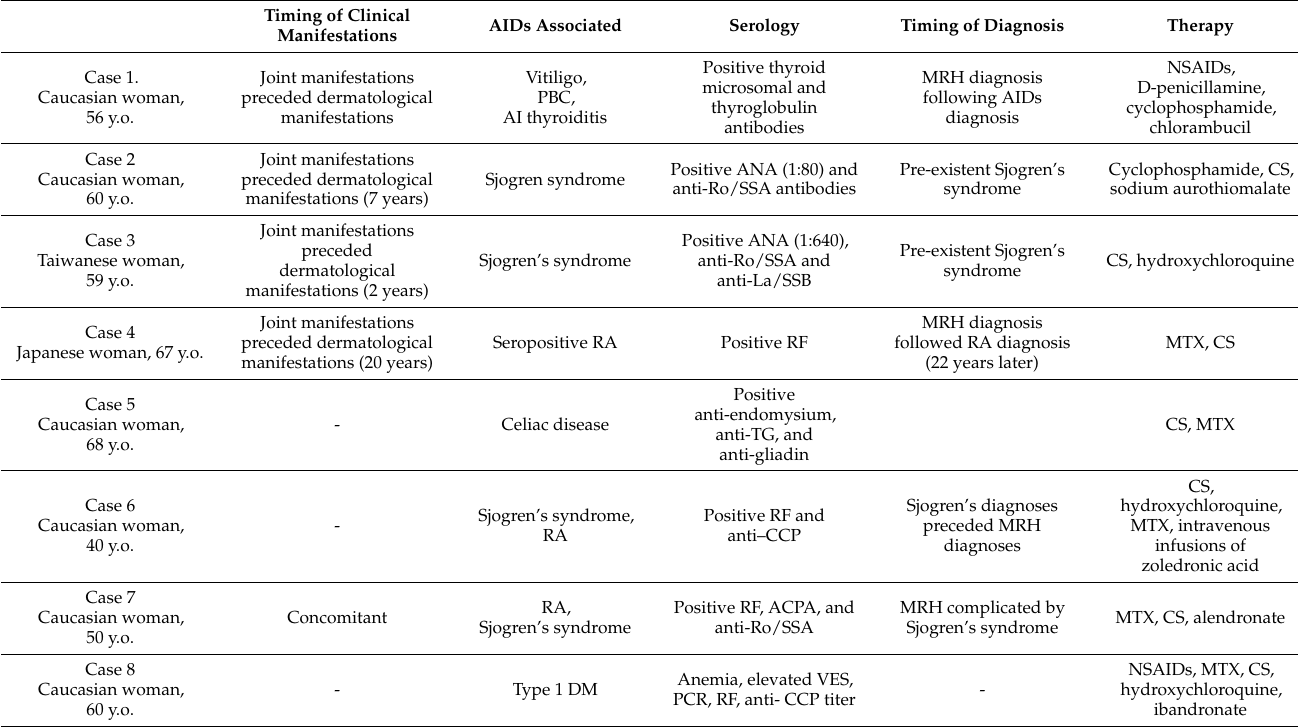
Table 1. Cases of MRH (Multicentric reticulohistiocytosis) associated with autoimmune diseases reported in the literature up until August 2022. Data adapted from the following articles: (1) MRH associated with primary biliary cirrhosis: successful treatment with cytotoxic agents [21]; (2) MRH associated with subclinical Sjögren’s syndrome [22]; (3) MRH in a Taiwanese woman with Sjögren syndrome [23]; (4) MRH associated with RA (rheumatoid arthritis) [24]; (5) Paraneoplastic multi- centric reticulohistiocytosis associated with a celiac disease [25]; (6) MRH: a systemic osteoclastic disease? [26]; (7) Case report of an association with erosive RA and systemic Sjogren syndrome [18]; (8) A Rare Case of MRH with Concurrent RA [27]; AIDs = autoimmune diseases; y.o. = years old; PBC = primary biliary cirrhosis; AI = autoimmune; RF = rheumatoid factor; CS = corticosteroids, MTX = methotrexate; TG = transglutaminases; DM = diabetes